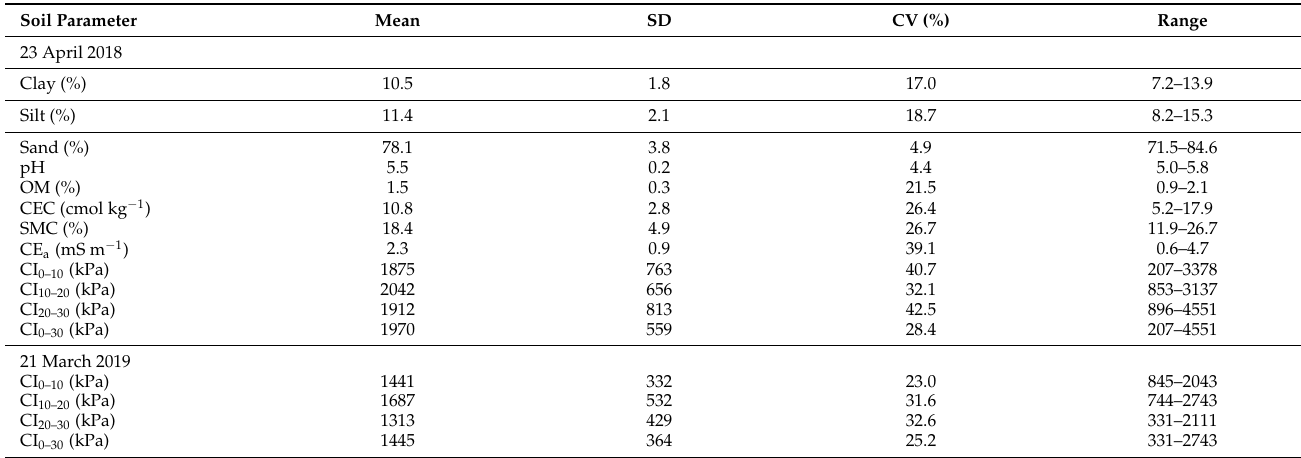
Table 1. Descriptive statistics of the soil parameters of the experimental field (0–0.30 m) in 2018 and 2019 surveys.